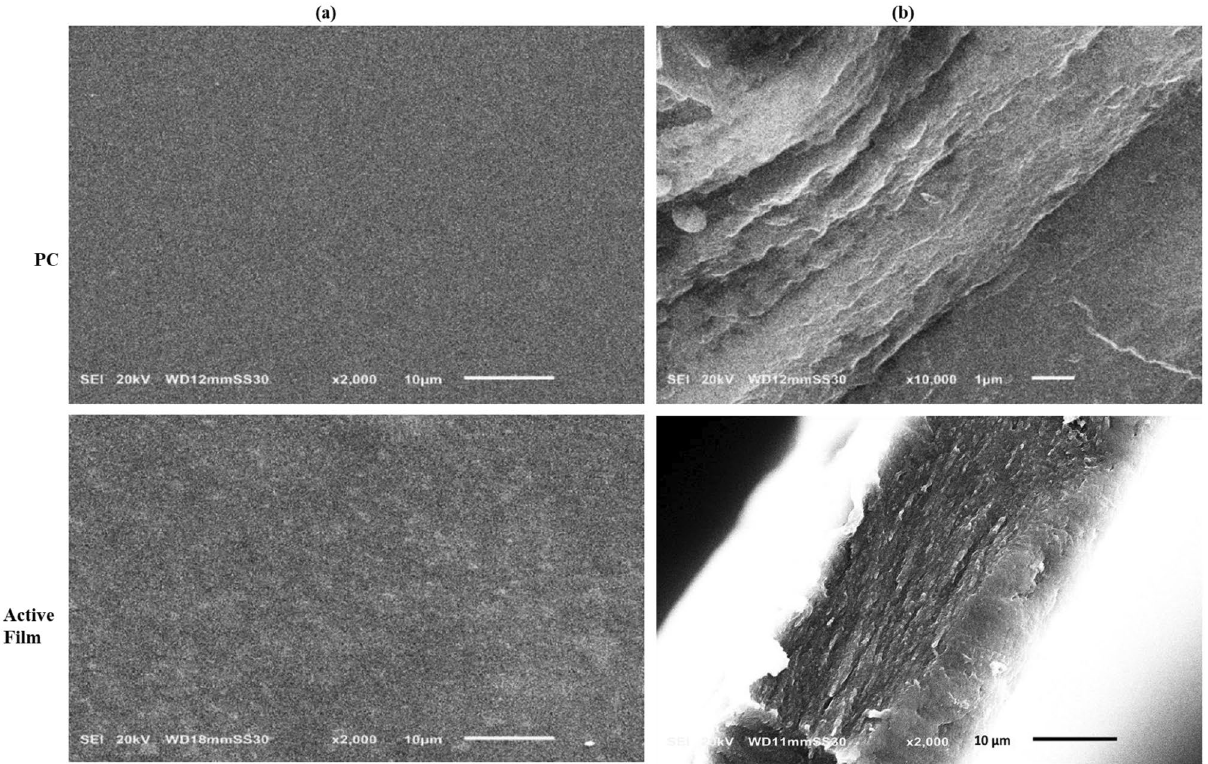
Figure 4. Surface morphology ( a ) and cross-sections ( b ) of SEM micrographs of PC and active film, respectively.